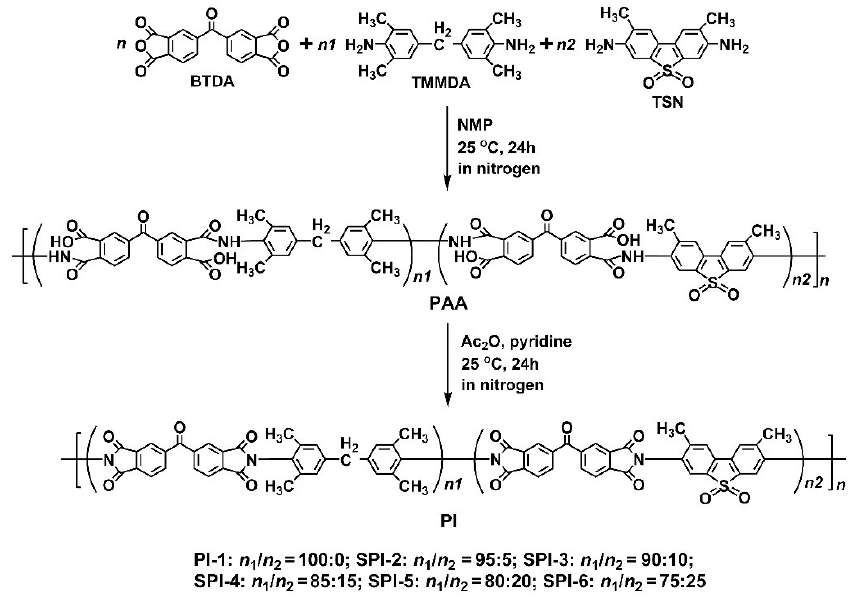
Figure 2. Synthesis of PI-1 (BTDA-TMMDA) and SPI copolymer resins. First, the inherent viscosities ([ η ] inh ) and molecular weights of the PI and SPI resins were detected, and the results are shown in Table 2. The copolymer PI (SPI-2~SPI-6) resins showed the ( η ) inh values in the range of 0.47~0.78 dL g − 1 , the number of average molecular weights ( M n ) in the range of (2.87~4.70) × 10 4 g mol − 1 , and the weight average molecular weights ( M w ) in the range of (5.13~8.83) × 10 4 g mol − 1 , respectively. These values are all correspondingly lower than those of the pristine PI-1 (BTDA-TMMDA) system (( η ) inh = 1.00 dL g − 1 , M n = 5.06 × 10 4 g mol − 1 ), indicating that incorporation of the TSN